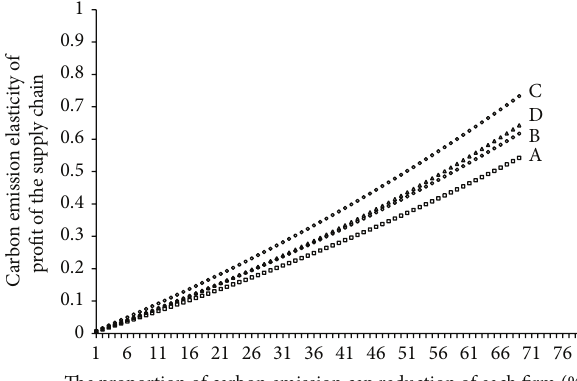
Figure 5: Carbon emission elasticity of profit with the respective reduction of emission cap of each company by a certain proportion.